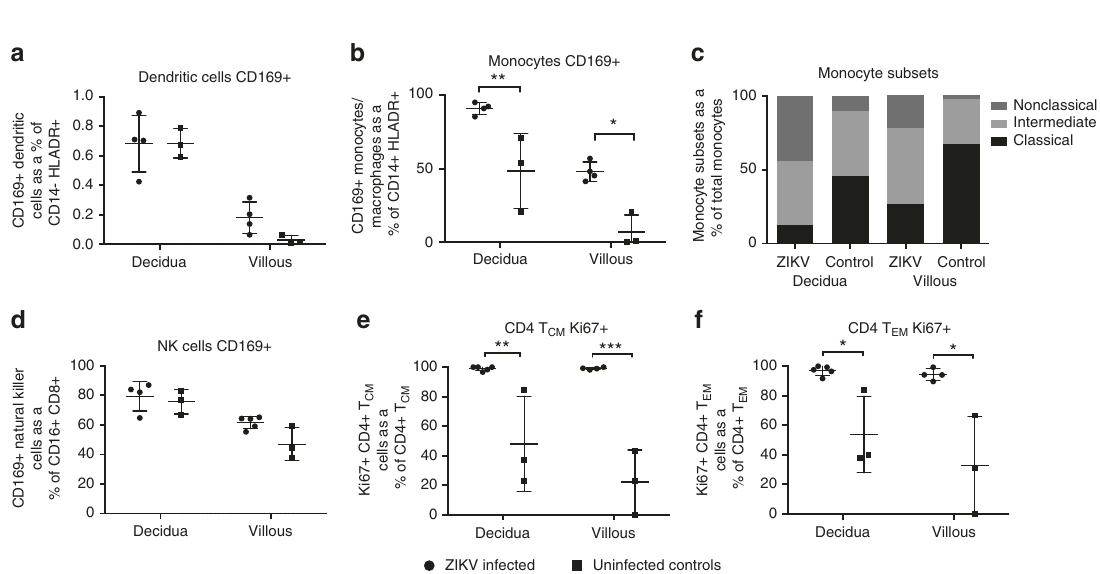
Fig. 2 ZIKV infection alters decidua and villous placenta monocyte and CD4+ T-cell populations and activation status. Decidua and villous placental lymphocytes were isolated from ZIKV-infected and control RM and analyzed by fl ow cytometry for the presence of the cellular activation marker CD169 on a dendritic cells; b monocytes; c monocyte subsets; and d NK cells, or the marker for Ki67 proliferation marker on e CD4+ central memory T cells and f CD4+ effector memory T cells. Cells were stained with a panel of antibodies recognizing HLA-DR, CD14, CD11c, CD123, CD20, CD3, CD16, and CD169 or a secondary panel containing CD3, CD4, CD8 β , CD95, CD28, and Ki67. One-way ANOVA was performed with Tukey ’ s multiple comparison test, bars represent mean and SEM, *** p < 0.001, ** p < 0.01, * p < 0.05 lymphocytes were also found (Supplementary Fig. 4c). In keeping with infectious virus recovery, placental cultures derived from animal D28380 contained the highest number of ZIKV E- expressing cells, possibly re fl ecting the time elapsed between maternal infection and tissue collection (21 days).